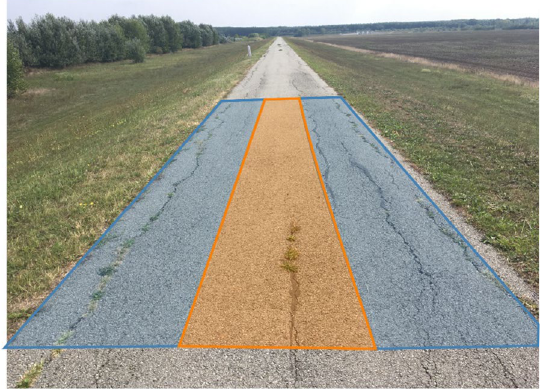
Fig. 2 Position of fissures on the paved dam crest